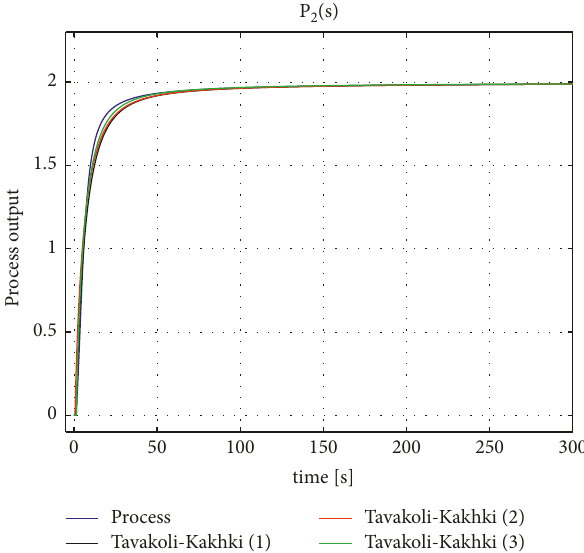
Figure 22: Process reaction curve and FFOPDT model methods # 7– # 9 step responses for process P 2 .